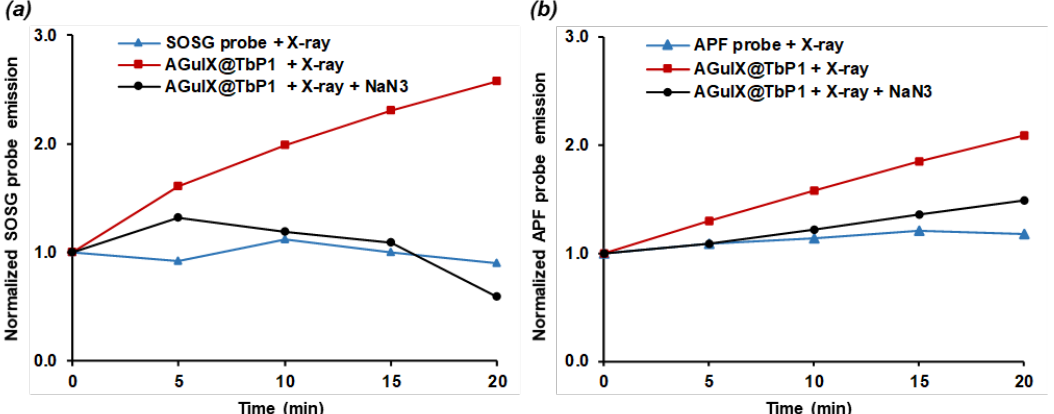
Figure 3. Kinetics of reactive species and singlet oxygen production under X-ray irradiation in water. Experiments were performed with 400 µM P1 equivalent AGuIX@Tb-P1 solution and probe fluorescence signals were revealed every 5-min during continuous X-ray irradiation. ( a ) 10 µM SOSG probe was used to react specifically to singlet oxygen. ( b ) 5 µM APF probe was used to assess reactive species production. Each fluorescence probe was irradiated alone. The production of singlet oxygen was inhibited by adding sodium azide (NaN 3 ) in the reaction mixture. Irradiation was performed with tube parameters set at 320 kVp, 12.5 mA, and 3 Gy/min.